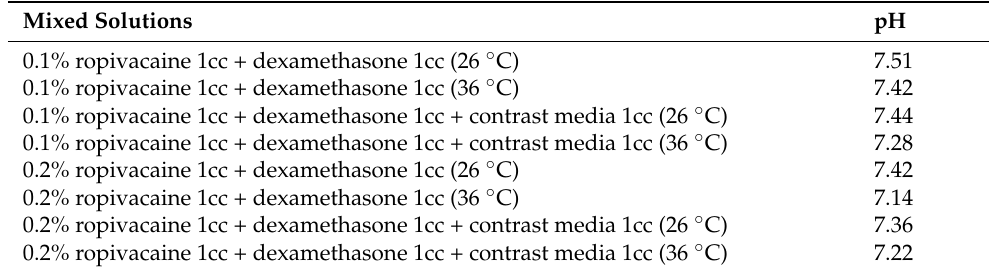
Table 2. Measurement of pH in the mixed solutions (ropivacaine, dexamethasone, contrast media). Mixed